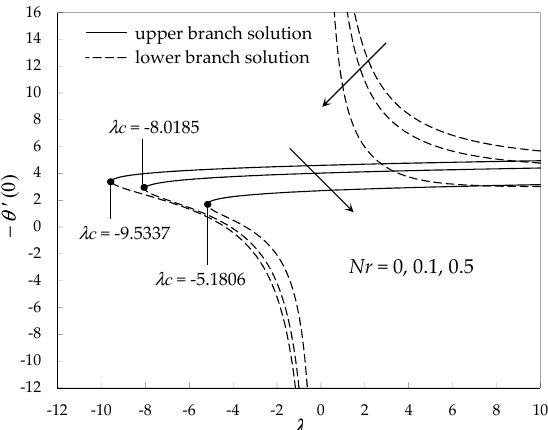
Figure 4. Variation of the reduced skin friction coefficient f (cid:48)(cid:48) ( 0 ) with the mixed convection parameter λ for several values of the radiation parameter Nr when φ = 0.01, K = − 0.1, s = 1 and c = − 1 for Cu-water nanofluid.